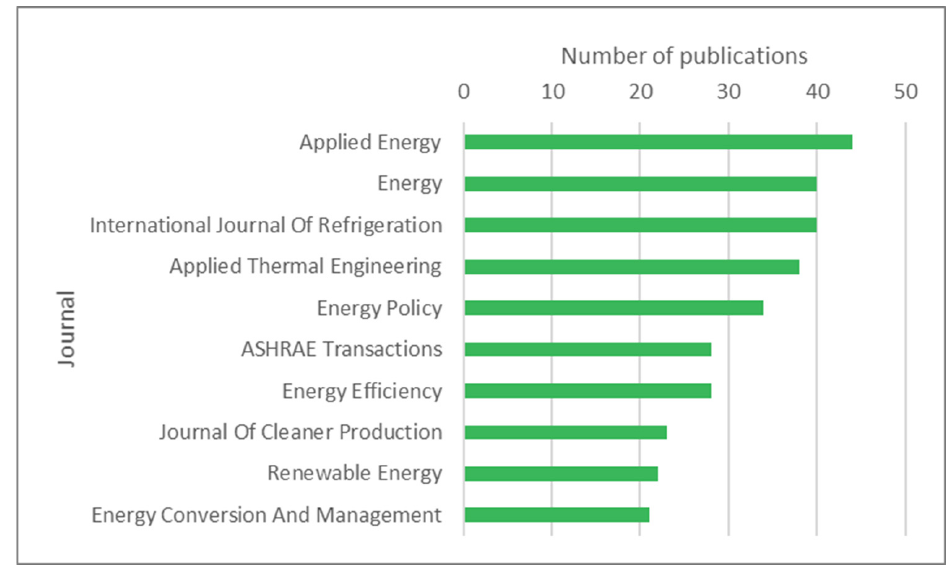
Figure 7. Journals where the documents are published. Table 4. The journals most used and their impact.